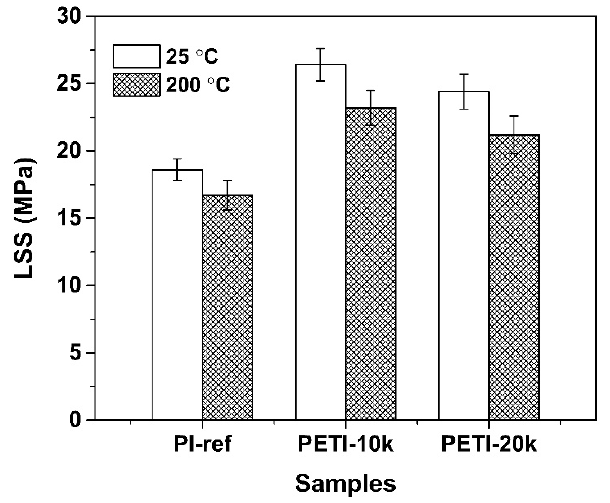
Figure 12. Lap shear strengths (LSS) of stainless steel adherends with electrospun PI nano-fibrous membrane adhesives.